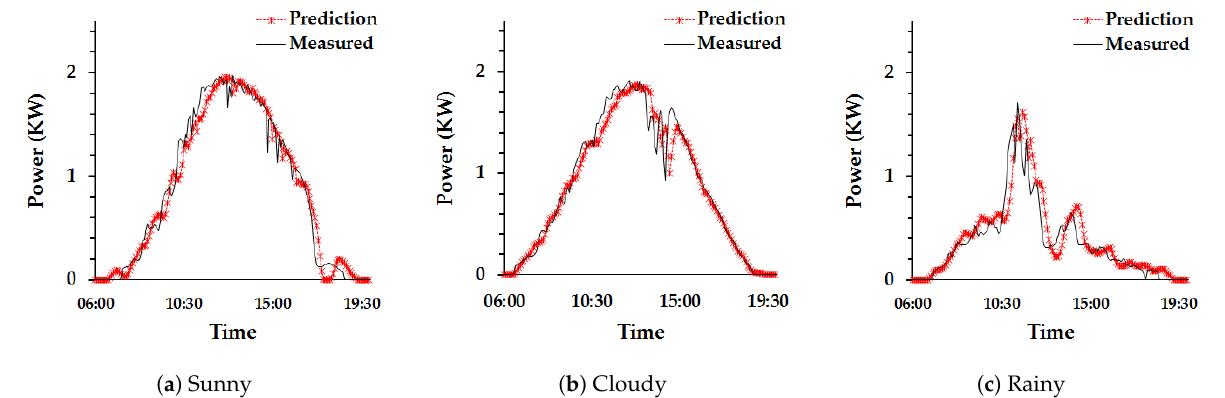
Figure 10. 15 min very short-term ahead forecast result of PV power generation (Layer = 3).